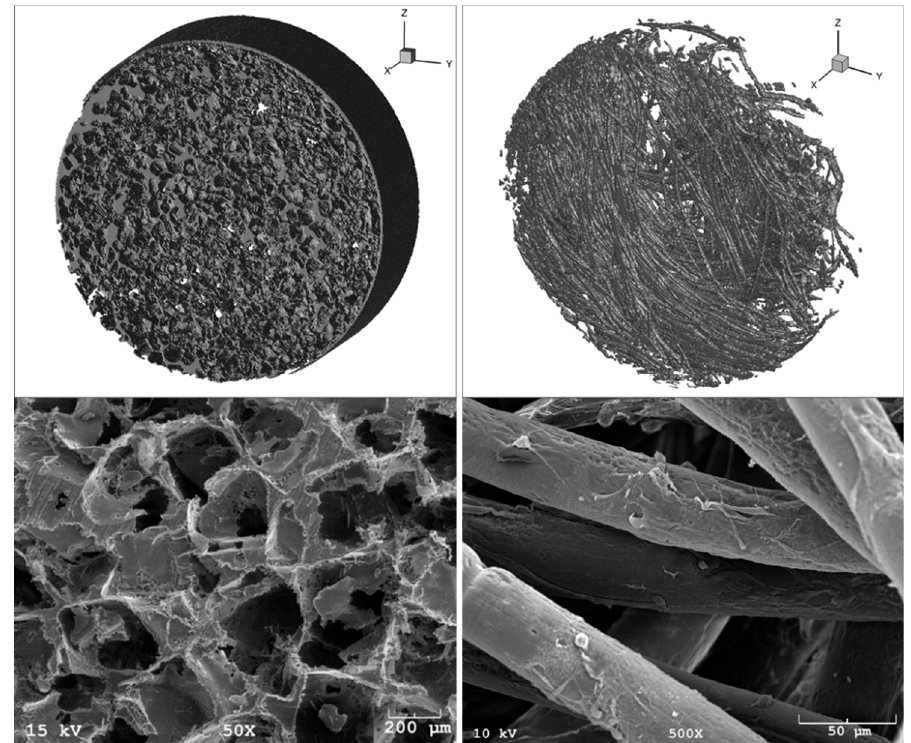
Figure 2. Visual comparison of the two sca ff old architecture types used in this study. LEFT COLUMN—Salt-Leached Porous Foam Sca ff old; RIGHT COLUMN—Non-woven Fiber Mesh Sca ff old. TOP ROW—Three dimensional reconstructions of 8-mm-diameter and 2.3-mm-thickness sca ff olds, obtained via µ CT imaging (described in our previous works [16,17,25]). BOTTOM ROW—SEM close-ups of representative regions on the sca ff olds’ surfaces. Images are shown at two di ff erent magnifications to illustrate morphological feature scales of the two sca ff old types. Both of the sca ff olds are made from poly-L-lactic